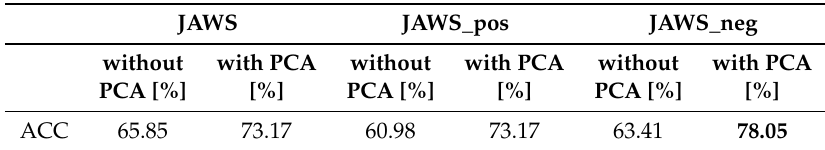
Table 8. Comparison of the division of the participants according to the classifier and performed by expert